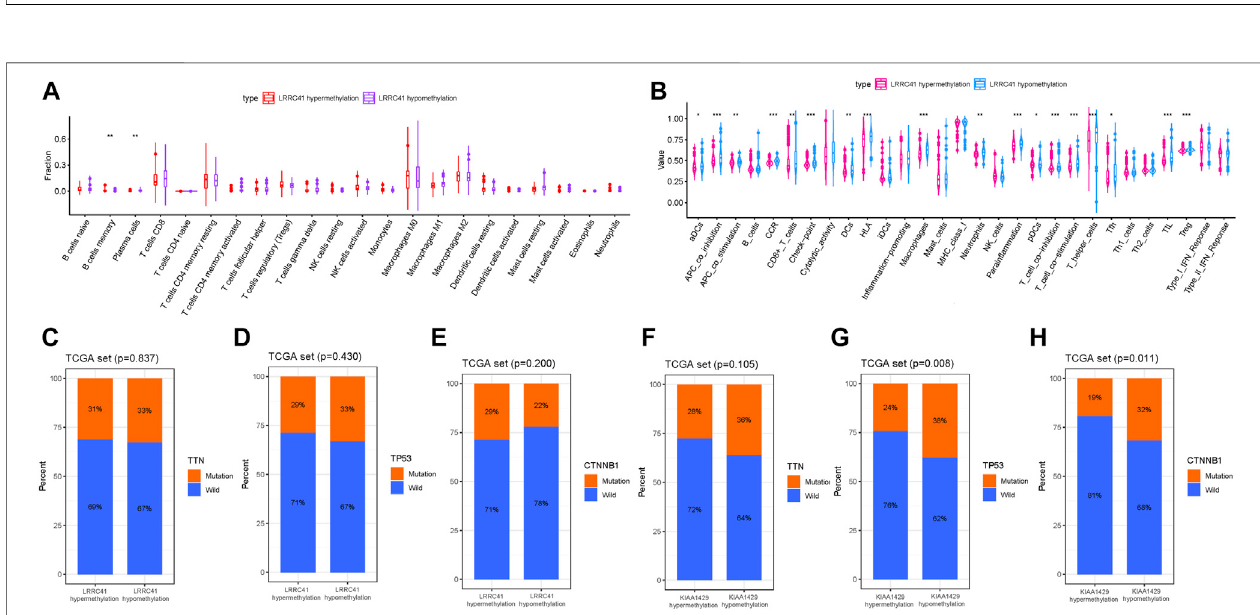
FIGURE 10 | Discrepancy of low and high LRRC41 methylation subgroups in terms of TIME characterization. (A) Comparison of CIBERSORT results in two LRRC41 methylation subgroups. (B) Difference of immune-related signatures between LRRC41 hypermethylation and LRRC41 hypomethylation subgroups. Correlation of candidate DNA methylation with gene mutated status. (C) Correlation of TTN mutation with LRRC41 methylation. (D) Correlation of TP53 mutation with LRRC41methylation. (E) CorrelationofCTNNB1mutationwithLRRC41methylation. (F) CorrelationofTTNmutationwithKIAA1429methylation. (G) Correlationof TP53 mutation with KIAA1429 methylation. (H) Correlation of CTNNB1 mutation with KIAA1429 methylation.